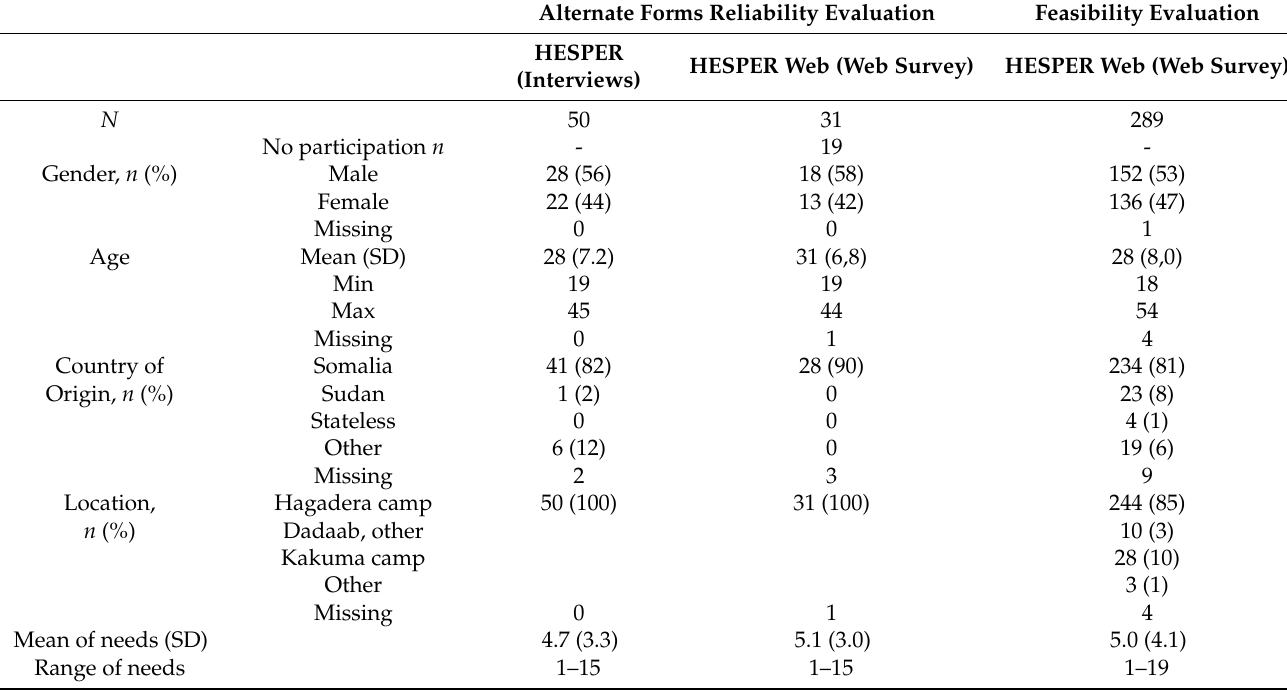
Table 1. Demographics of the study participants.